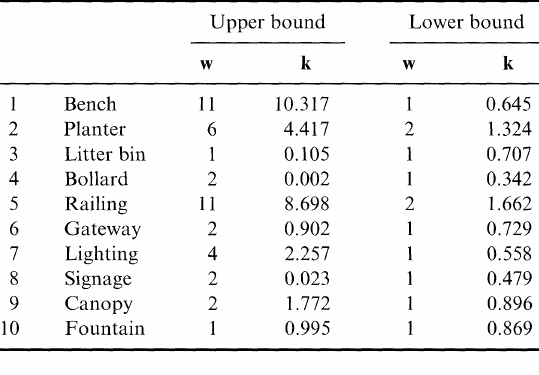
TABLE III Integer proportions of feasibility bounds for sel- ected furniture distribution, w0 Upper